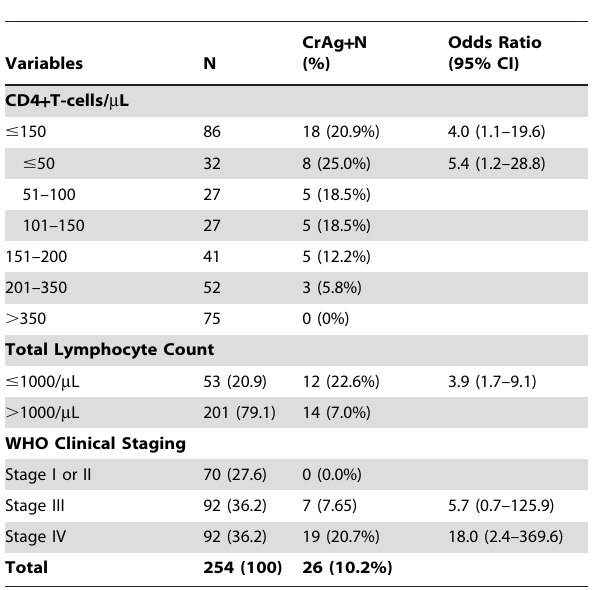
Table 3. Association of Serum CrAg Positivity with Degree of